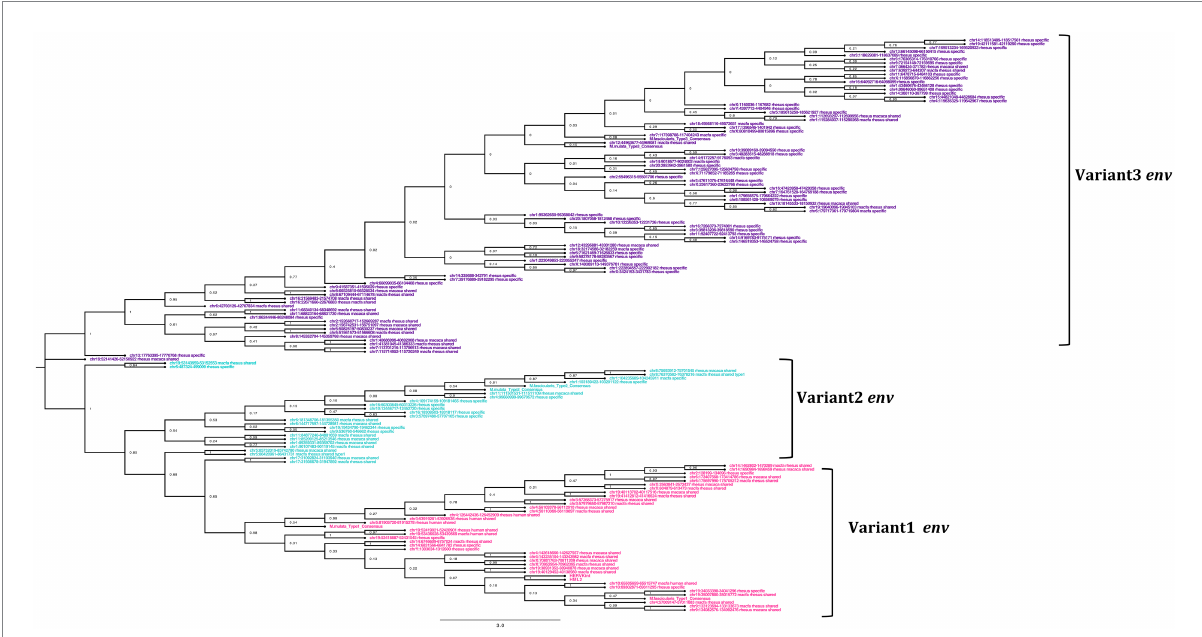
FIGURE 6 Phylogeny of the env gene of HML2 in Macaca fascicularis and Macaca mulatta . The clusters indicate the presence of 3 subtypes of env in Old World Monkeys. The type1 (pink) is similar to the human HML2 type2 (rec) env , while type 2 (cyan) has specific insertions in the transmembrane region, and type 3 (purple) which forms the largest cluster mostly species-specific and some shared between the two macaques having HERVK11